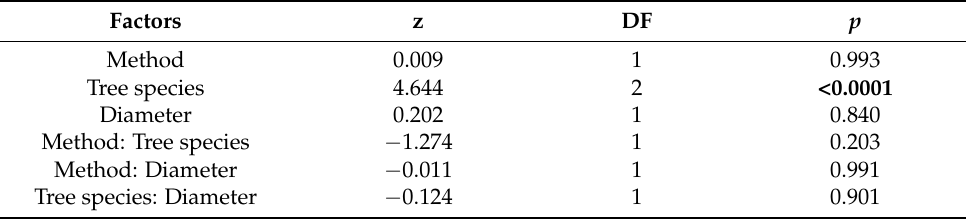
Table 1. Statistical values from the generalized linear mixed model (binomial distribution) for the presence or absence of immatures of Agrilus spp. detected in ash and paper birch with CT-scan and debarking. p values considered significant (<0.05) are shown in bold.